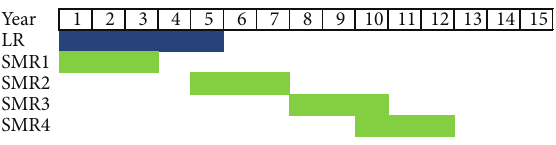
Figure 5: Construction schedules: reference scenario.